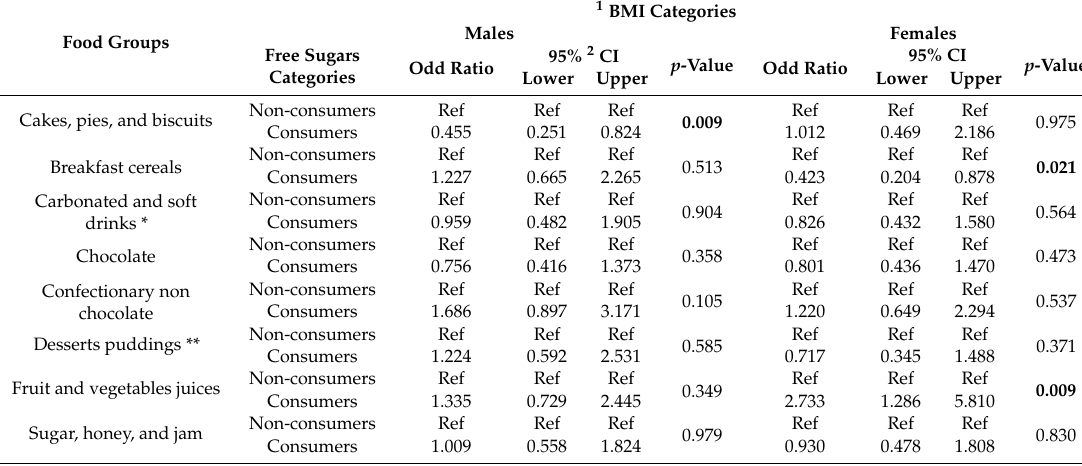
Table 5. The association between free sugars consumption from the main food group categories (non-consumer vs. consumer) and BMI categories between gender using country as a level.